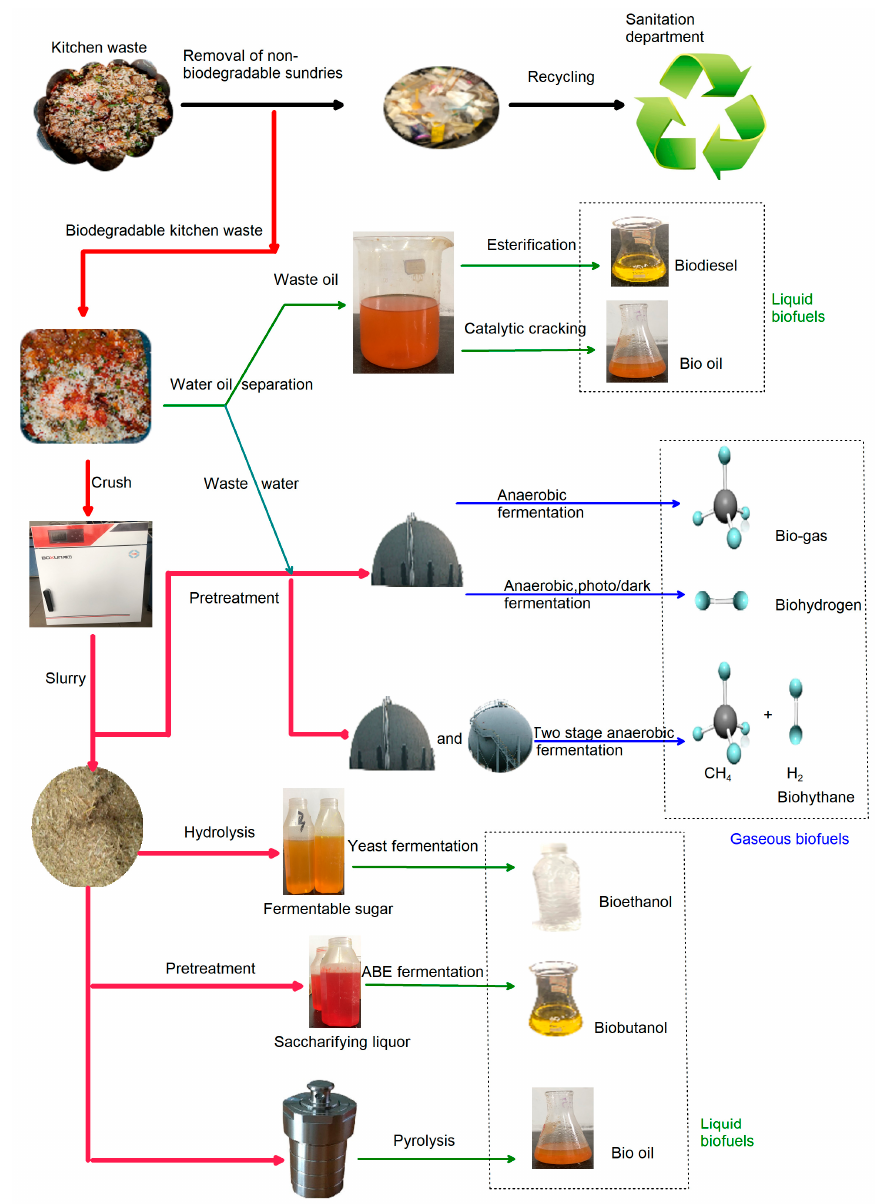
Figure 2. General route for preparing biofuels from kitchen waste.